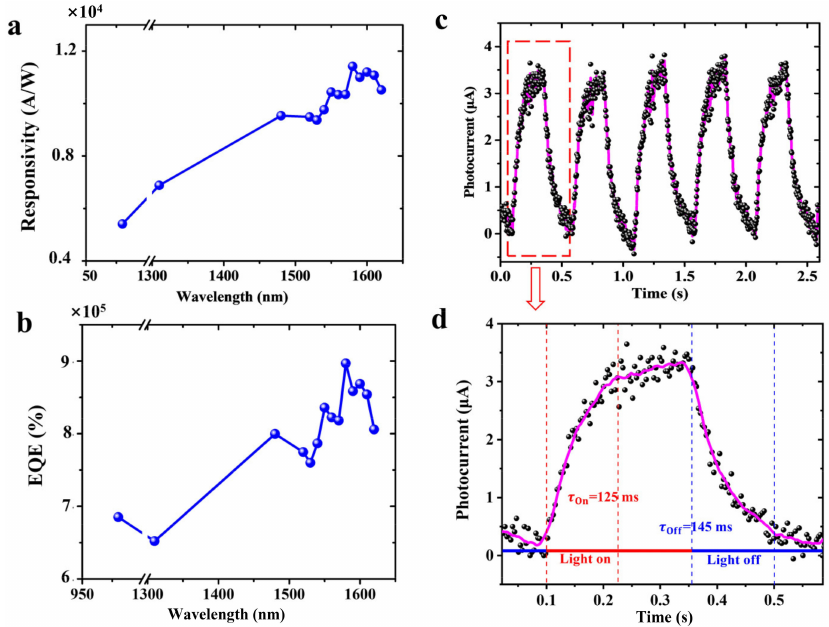
Figure 3. Broadband and transit response of the AFPD. Responsivity ( a ) and EQE ( b ) of different wavelengths when the incident power is fixed at 1 nW. ( c ) Time-dependent photocurrent over a 5-period on–off operation at 1550 nm. ( d ) Zoomed-in view of photocurrent determining the rise and fall times as 125 and 145 ms,